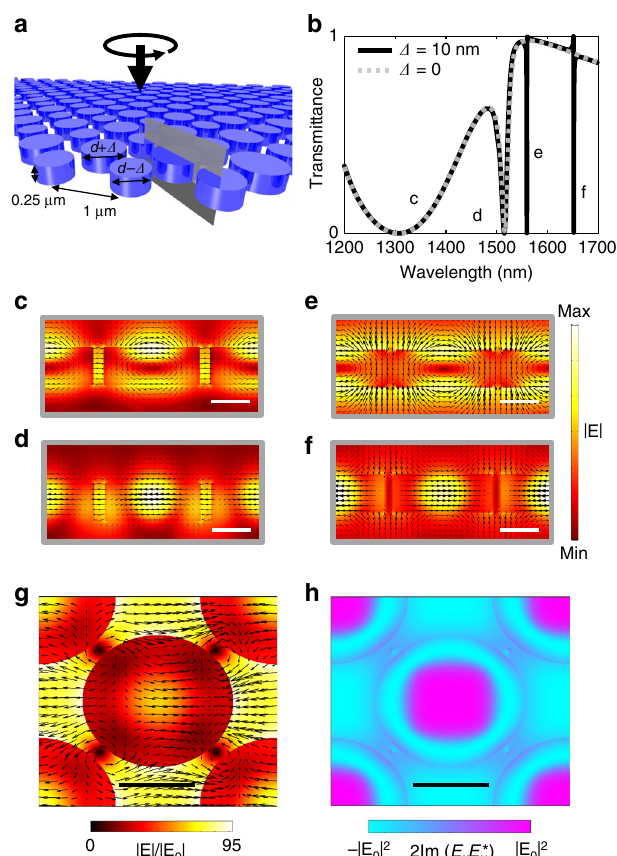
Fig. 2 Simulating linear behavior of high Q silicon metasurface. a Schematic of silicon metasurface, d = 640 nm. b Circularly polarized transmission through metasurface with Δ = 0 (dashed gray curve) Δ = 10 nm (solid black curve). c – f Electric fi eld distributions, with colourmaps giving amplitude and vector directions given by arrows, in the x = y plane, shown in gray in a , for the four resonant modes in b . From the electric fi eld vector maps, it can be seen that c and d are symmetric magnetic and electric dipoles, respectively, while e and f are anti-symmetric magnetic and electric dipoles, respectively. Scale bars are 250 nm. g On resonant electric fi eld map at the z = 0 plane for mode f . Scale bar is 325 nm long. h E- fi eld spin corresponding to the map in g . Scale bar is 325 nm